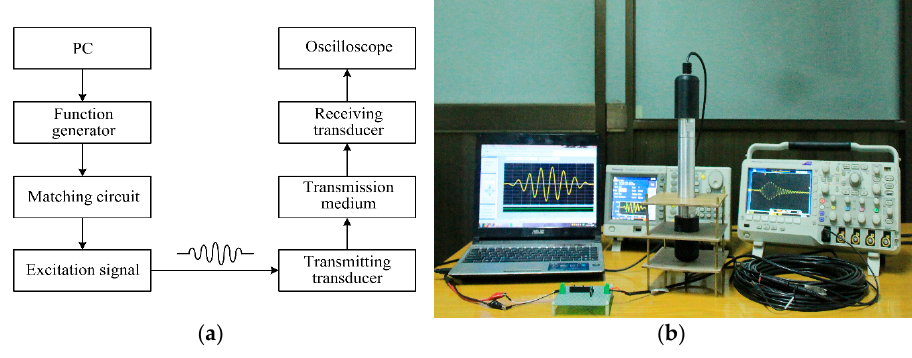
Table 6. The received voltages of measured and simulated for the pitch-catch setup.